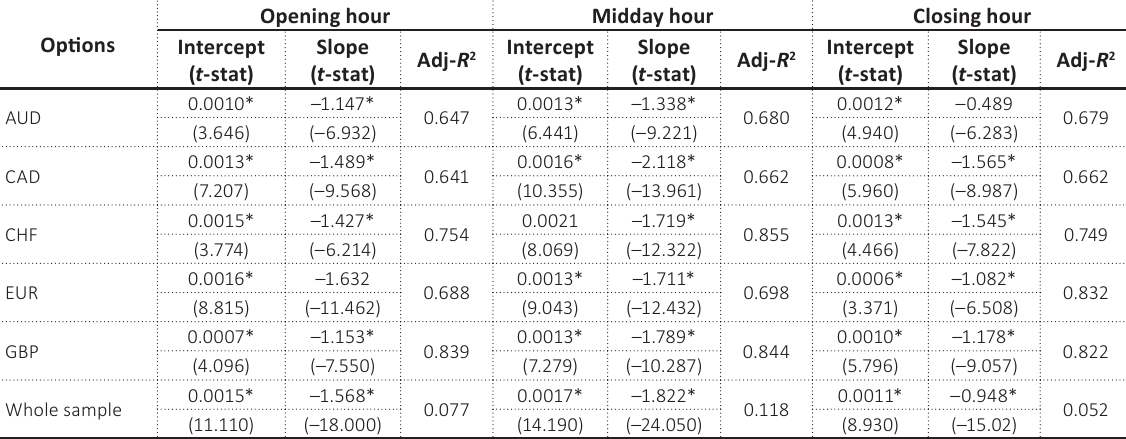
Table 3. Currency smirks’ information content analysis